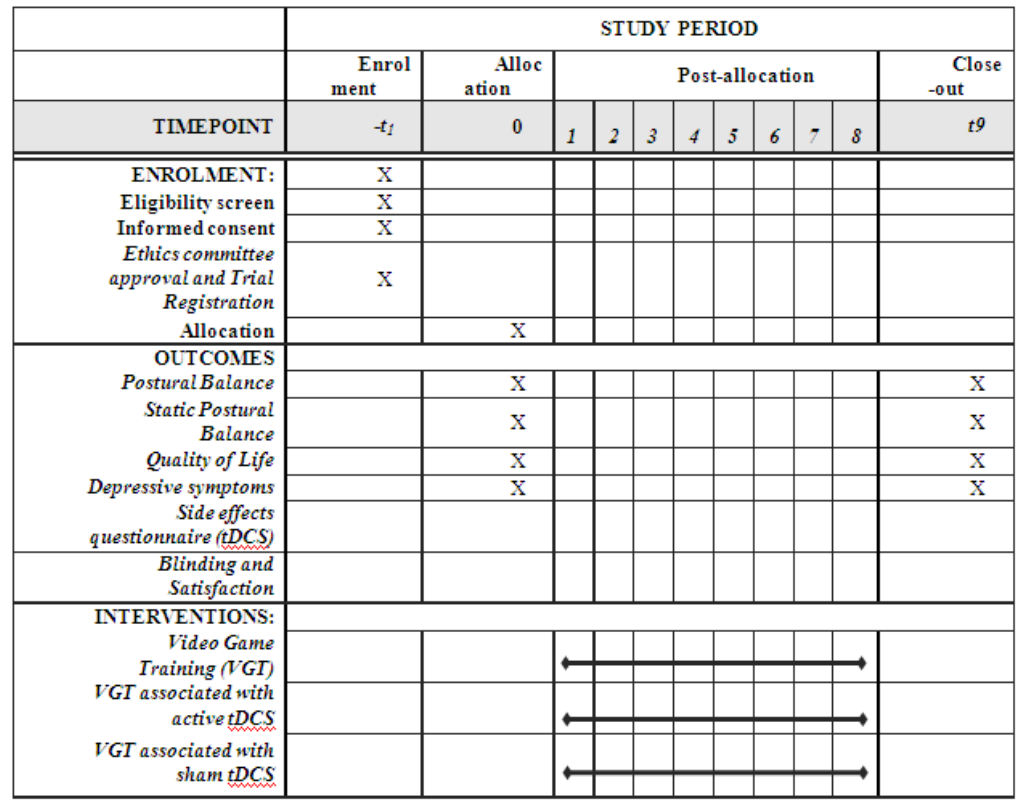
Figure 1. Study enrollment schedule, outcomes, and interventions. tDCS. transcranial direct current stimulation.